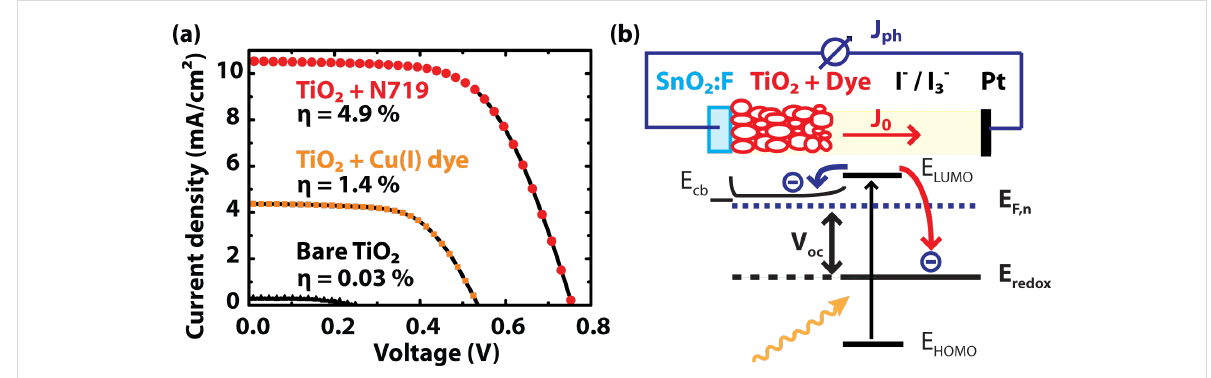
Figure 9: (a) I – V curves for a bare TiO 2 solar cell and DSCs sensitized with Cu(I) dye and N719. (b) A schematic band diagram for a DSC under light excitation of the dye. The desired forward reaction (blue arrow), i.e., electron transfer from E LUMO into the conduction band, E cb of TiO 2 , is accompa- nied by a backward electron injection (red arrow) from E LUMO into E redox .